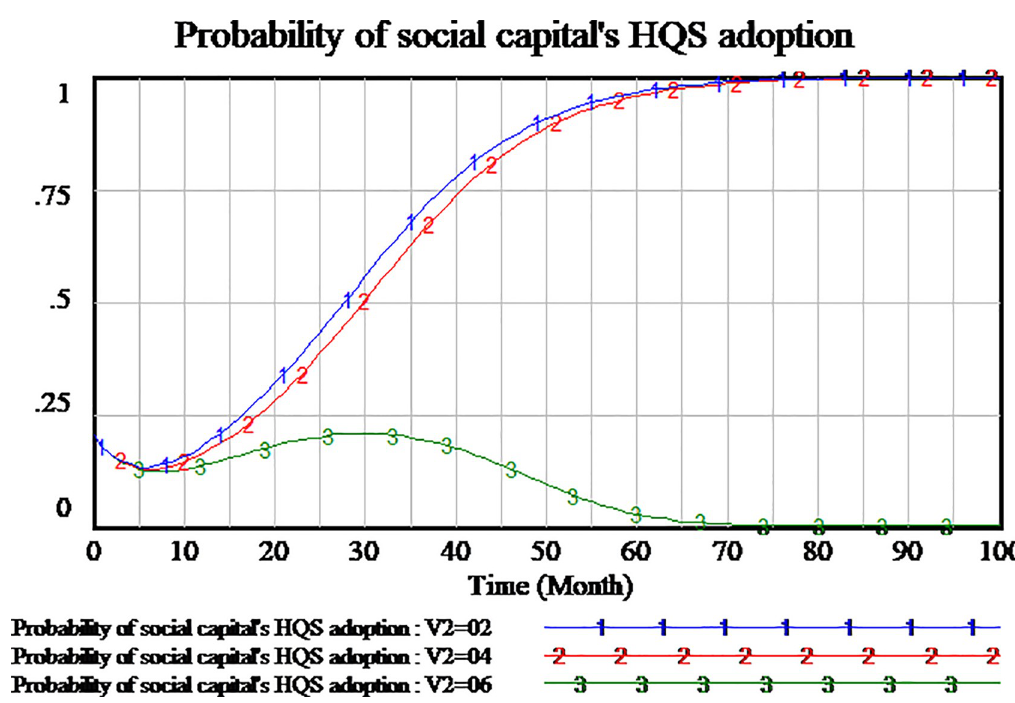
Fig 12. Impact of different compensation on social capital.